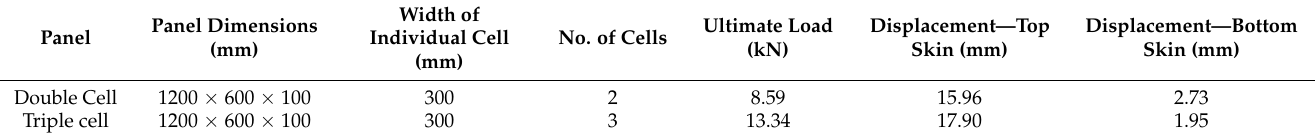
Table 5. Comparison of average load vs. displacement values for double cell and triple cell